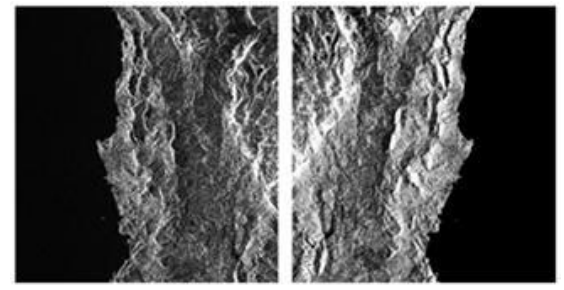
Figure 5. SAR imagery (left: original SAR data right: preprocessed SAR data